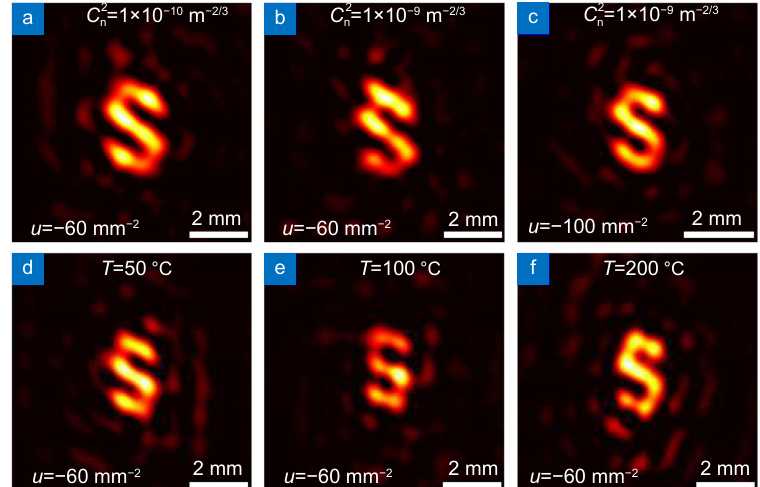
Fig. 7 | ( a − c ) Simulation results of the reconstructed image in turbulence of different strength and with different CP strength factor u. ( d − f ) Experi- mental results of the reconstructed image at different temperatures with u =−60 mm −2